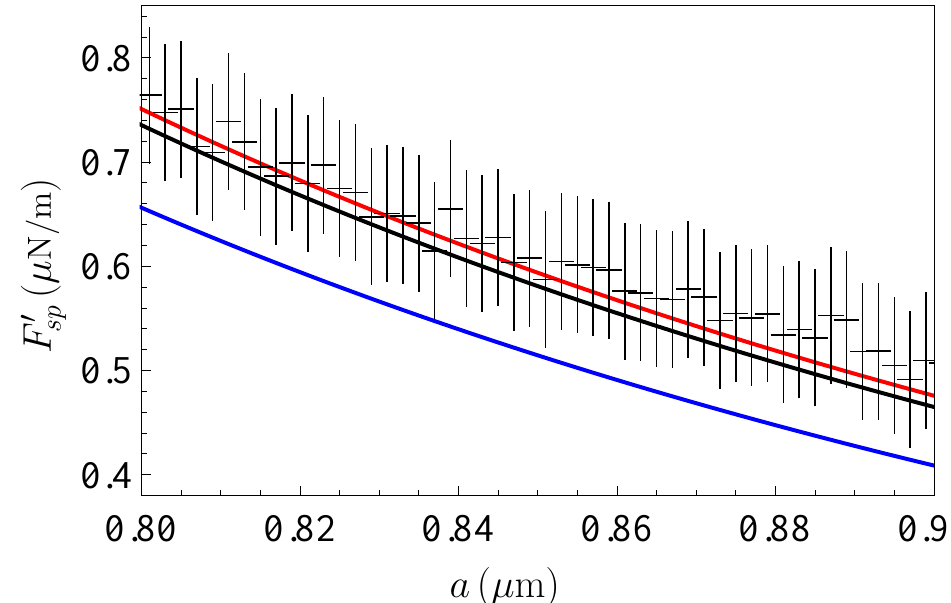
Figure 9. The gradients of the Casimir force between an Au-coated sphere and an Au-coated plate measured by means of an atomic force microscope [85] (crosses) compared with theoretical predictions of Lifshitz theory using the extrapolation of the optical data of Au by means of the nonlocal Drude-like response functions (black band). The theoretical predictions using the Drude and plasma extrapolations are indicated by the blue and red bands,